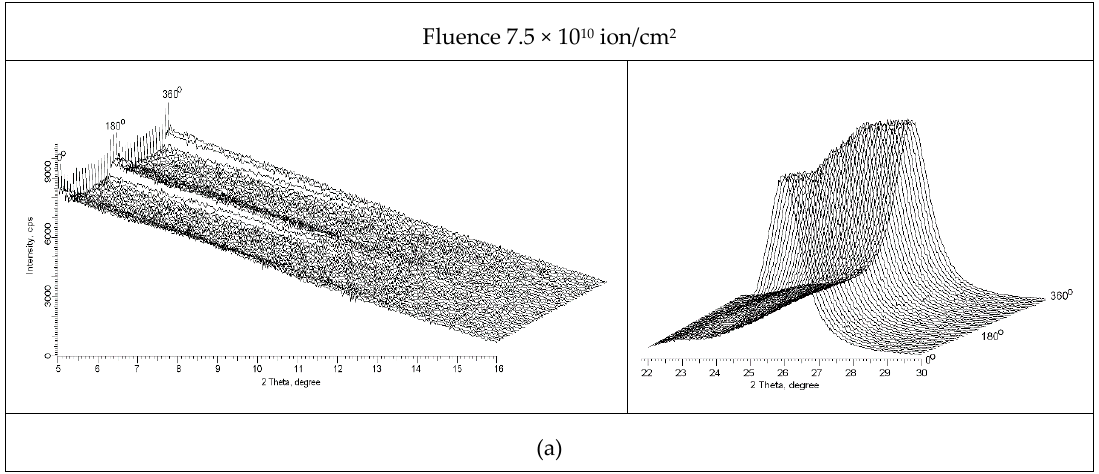
Figure 3. Azimuthal variations in the intensity of diffraction reflections (black line – initial sample; red line – irradiated by Kr 13+ ions; blue line – irradiated by Kr 14+ ions; green line – irradiated by Kr 15+ ions): ( a ) 5.0 × 10 10 ion/cm 2 ): ( b ) 7.5 × 10 10 ion/cm 2 ; ( c ) 1.0 × 10 11 ion/cm 2 ; ( d ) 2.5 × 10 11 ion/cm 2 ; ( e ) 5.0 × 10 11 ion/cm